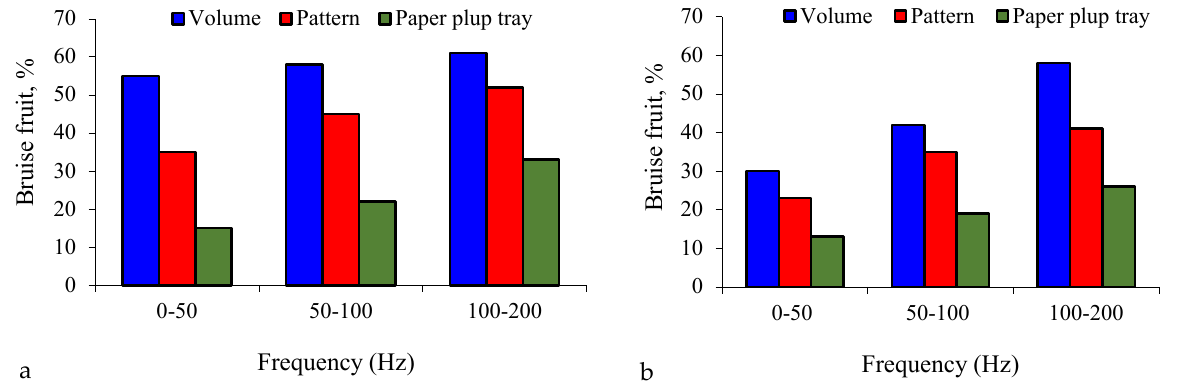
Figure 16. The effect of the vibration frequency on the number of cantaloupe bruised at different packaging method and duration: ( a ) 5 min; ( b ) 10 min.